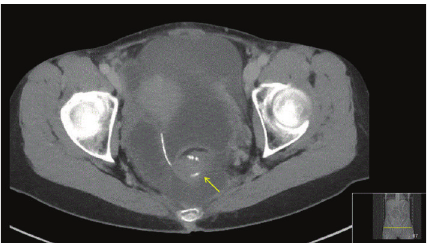
Figure 1: CT-scan showing volvulus of the pelvic pouch apparent by twisting of the posterior staple line 270 degrees just above the level of the ileoanal anastomosis (arrow).